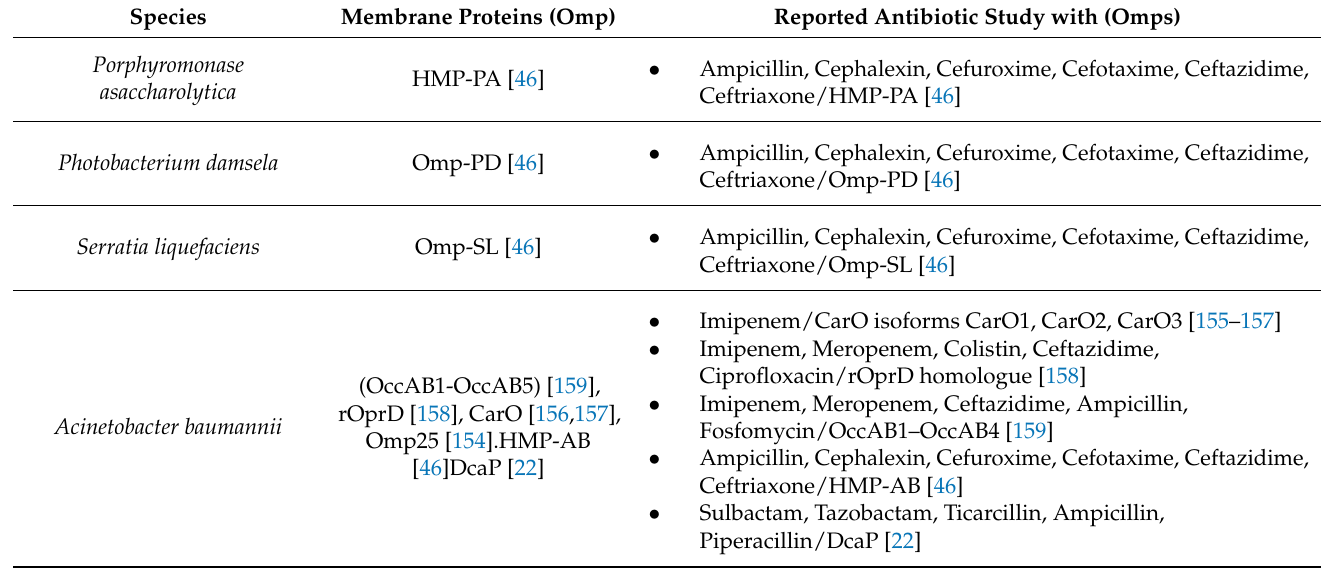
Figure 2. Electrophysiology experiment overview ( A ) Current records from a bilayer in symmetric salt solution at t = 0. After 300 s., Stepwise channel insertion into the bilayer. ( B ) Current amplitude histogram of the ion current trace ( A ). ( C ) Current recordings from a bilayer containing single membrane OmpF channel with Ampicillin. ( D ) Current recordings from a bilayer containing single membrane OmpF channel with degraded Ampicillin. Original figures by author. The figures are only for representations, not experimental data explained here. For the experimental explanation for ( A , B ), please see references [69] ; for ( C , D ), see reference [54] . Table 2. Crucial Membrane Proteins and antibiotic membrane protein (Omps) combinations were studied in different Species of Gram-negative bacteria, building upon and updating earlier published research by the author [27,45]. The author has endeavored to gather as much data as possible, and the citations provided are accurate to the best of the knowledge. However, any errors in the citations or table are beyond the author ’ s control. Additionally, it should be noted that while this Table is included, the list may not be limited.